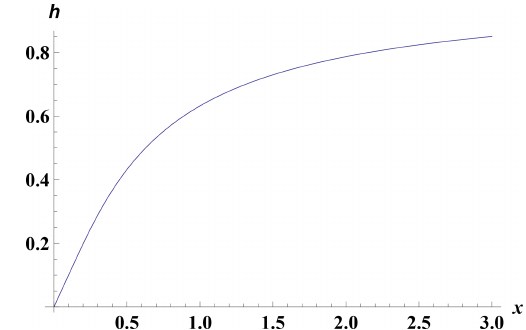
Figure 10. One-box vs. two-box model in response to kink-linear forcing as a stylized interpretation of mitigation-oriented forcing paths and for equal levels of ECS and TCR in both models. Kink- linear curve: two-box model; smooth curve: one-box model. The temperature development of the one-box model overshoots the max- imum of the two-box model by roughly